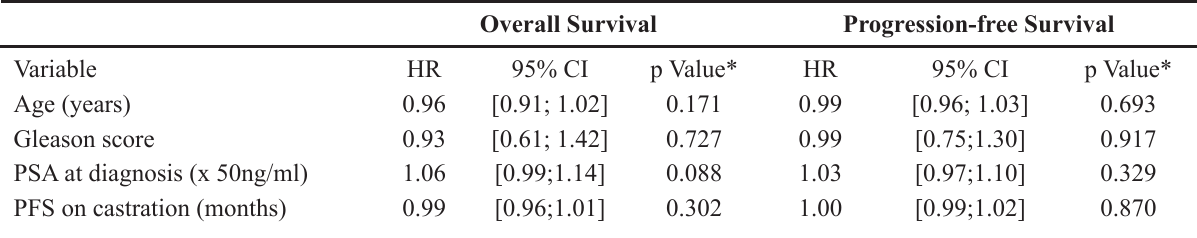
Table 2 – Effect of clinical variables on progression-free survival and overall